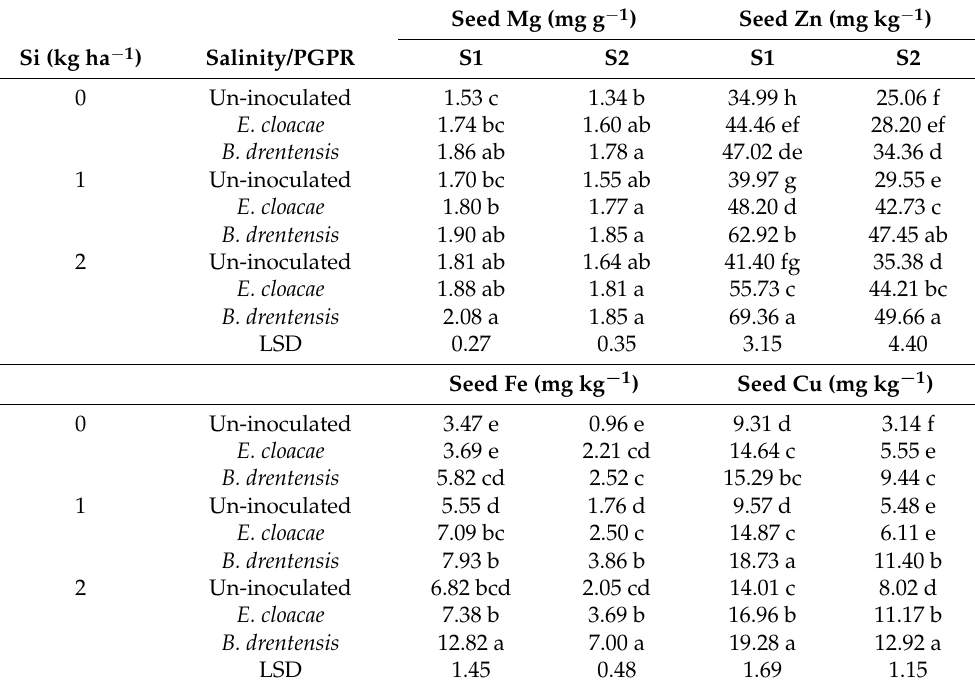
Table 3. Effect of silicon foliar spray and PGPR inoculation on mineral content of mung bean seed under saline irrigation